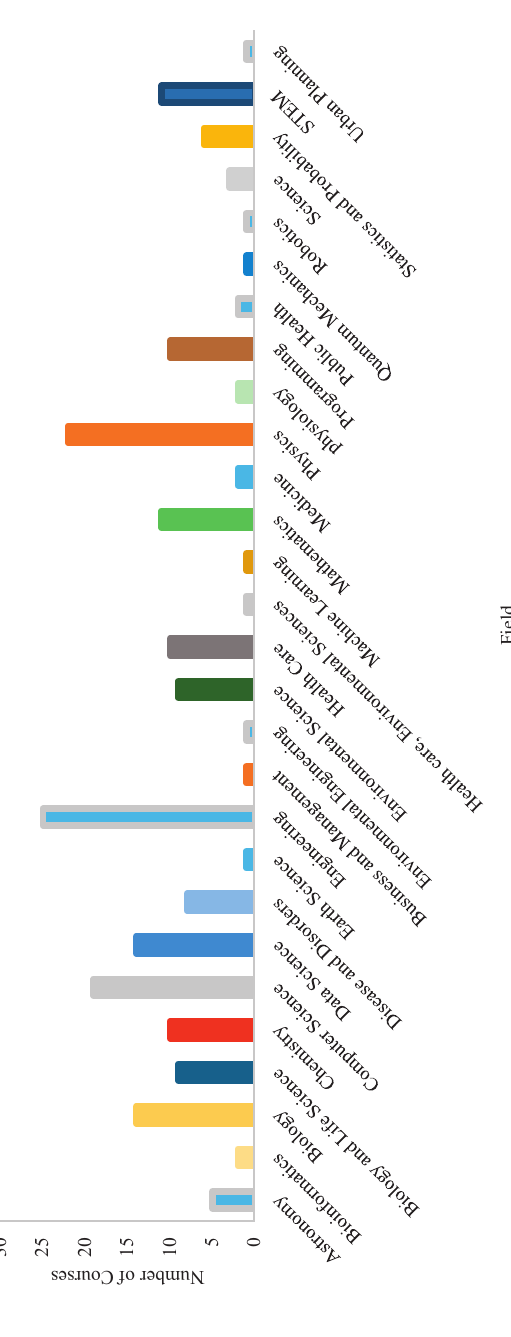
Figure 1. STEM E-courses provided by different